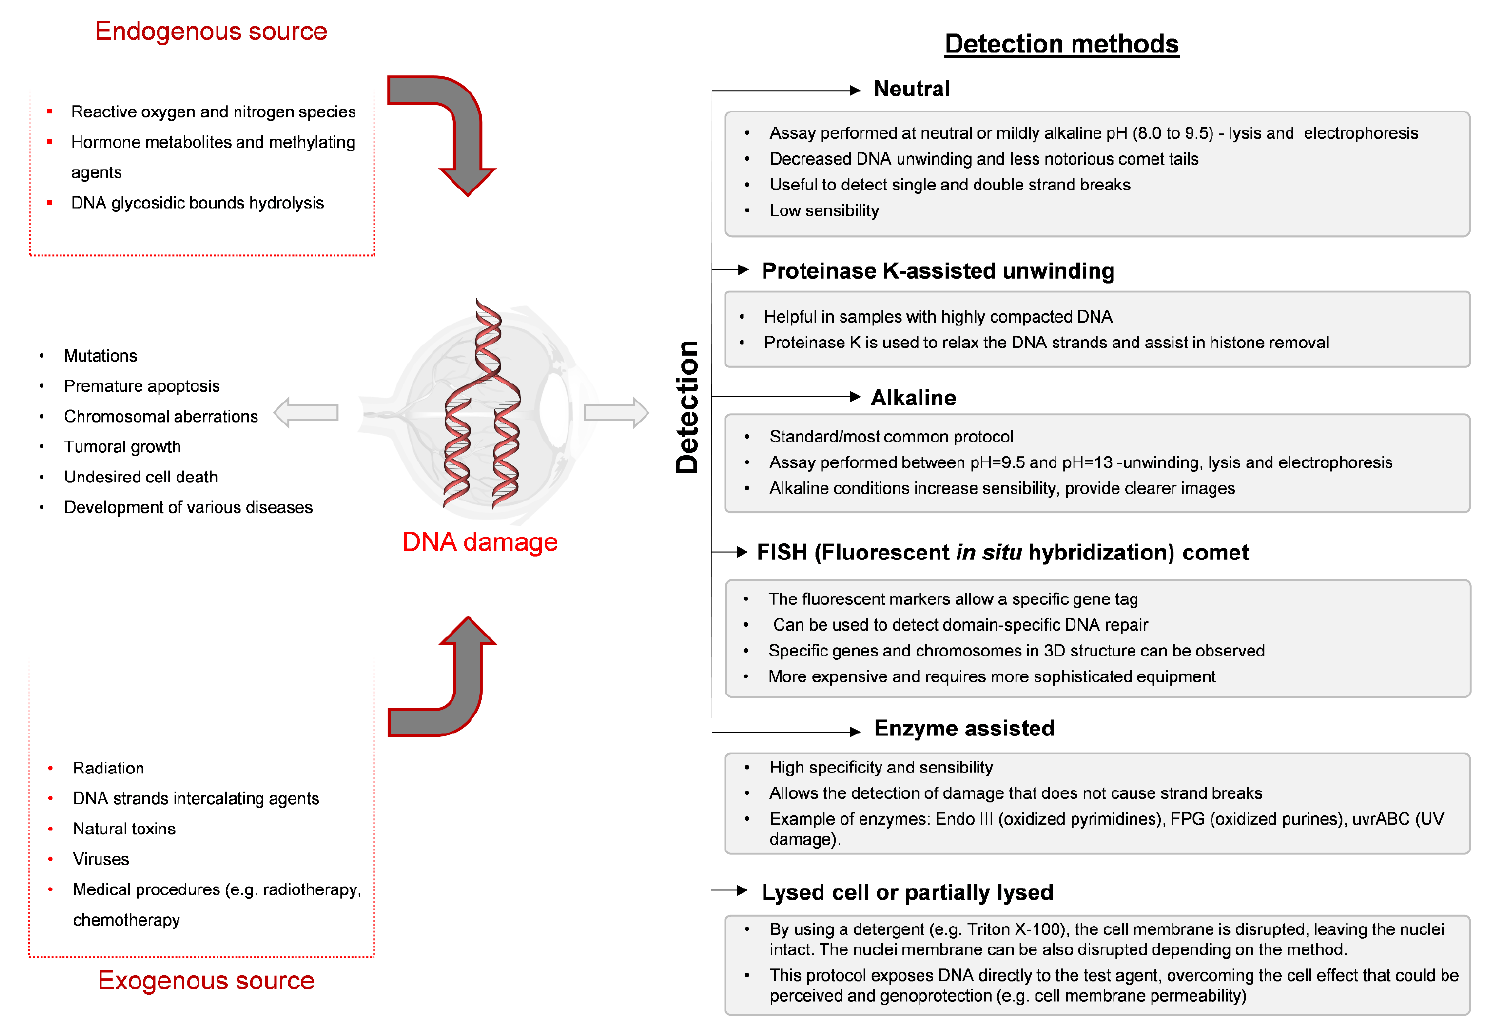
Figure 2. Sources of DNA damage and detection methods in comet assays.